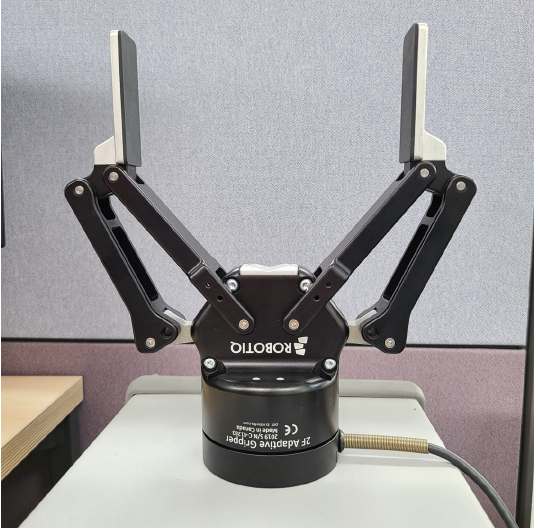
Figure 3. The gripper used in the proposed system is Robotiq’s 2F-140